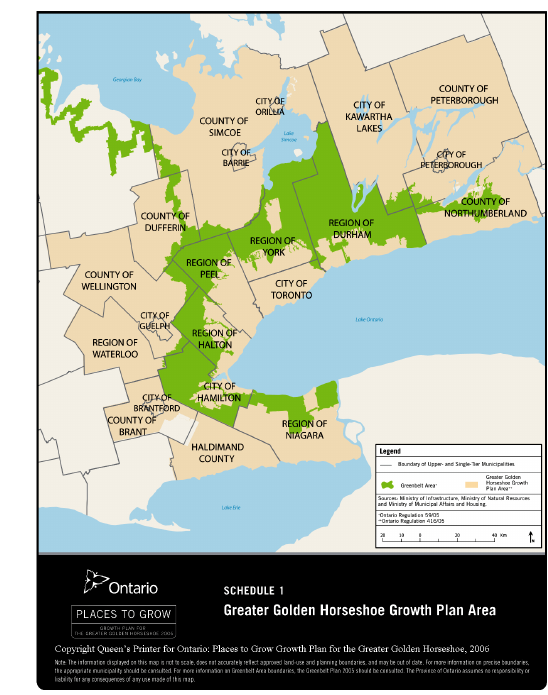
Fig. 4 . The Greater Golden Horseshoe area. (Source: Ministry of Public Infrastructure Renewal (2006: Schedule